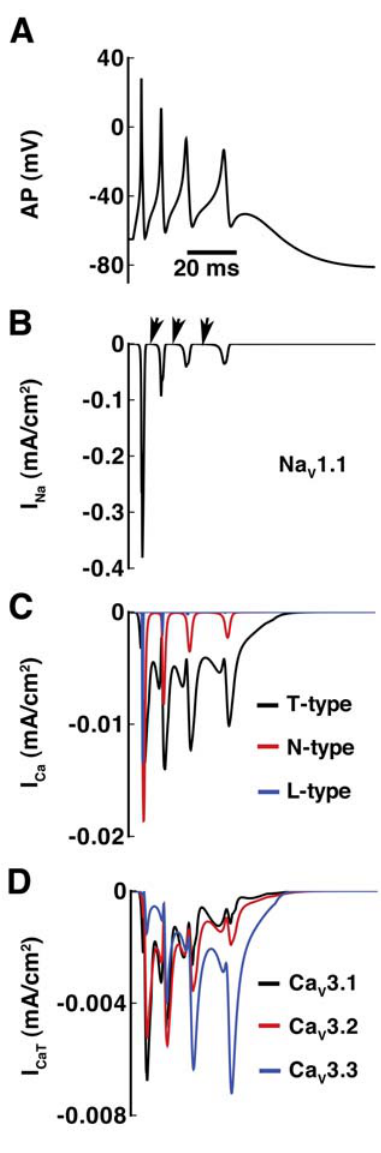
Figure 4. The ionic mechanism of bursting in the CA3 neuron . (A) The membrane potential in response to a brief current injection (0.2 nA for 5 ms). (B) The Na + current in the neuron consists of Na V 1.1 current. During the interspike interval, the current through Na V 1.1 returns to zero (arrows). (C) T-type (black), N-type (red), and L-type (blue) Ca 2 + currents during burst. Note that the L- and N-type Ca 2 + currents are much smaller than the T-type Ca 2 + current (black line) during the interspike intervals. (D) The three T-type Ca 2 + current subtypes Ca V 3.1, Ca V 3.2 and Ca V 3.3.